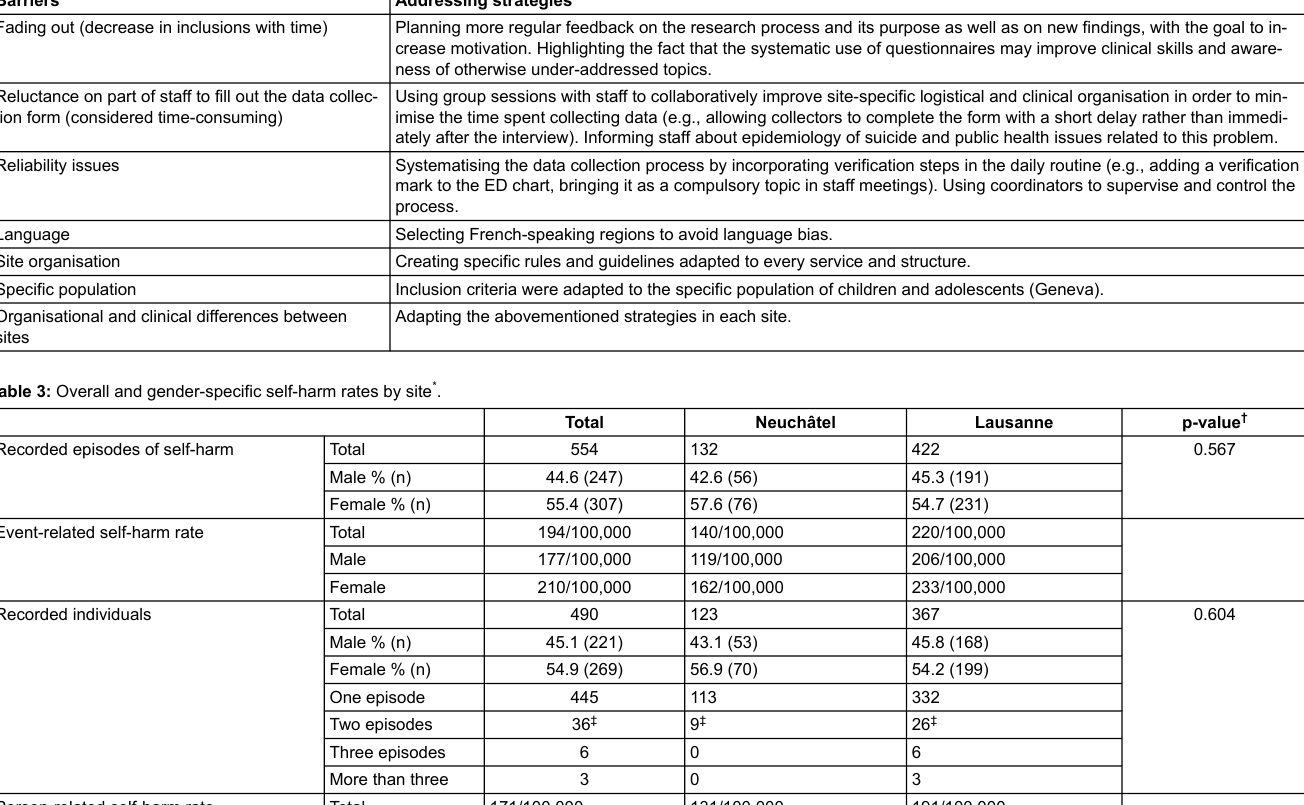
Table 2: List of identified barriers related to implementation. Barriers